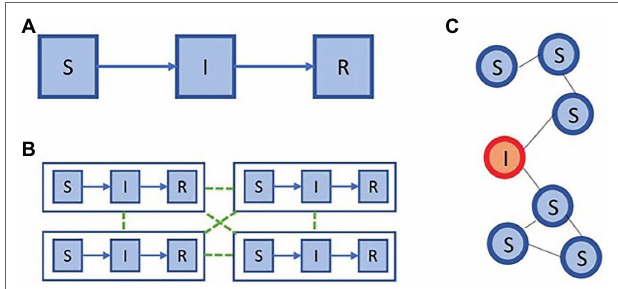
FIGURE 6 | Modelling impact on policy. Two extremes in model space: (A) an SIR compartment model, (C) and individual-based model. We show a meta population model (B) , that is situated between the models in (A,C) , in terms of